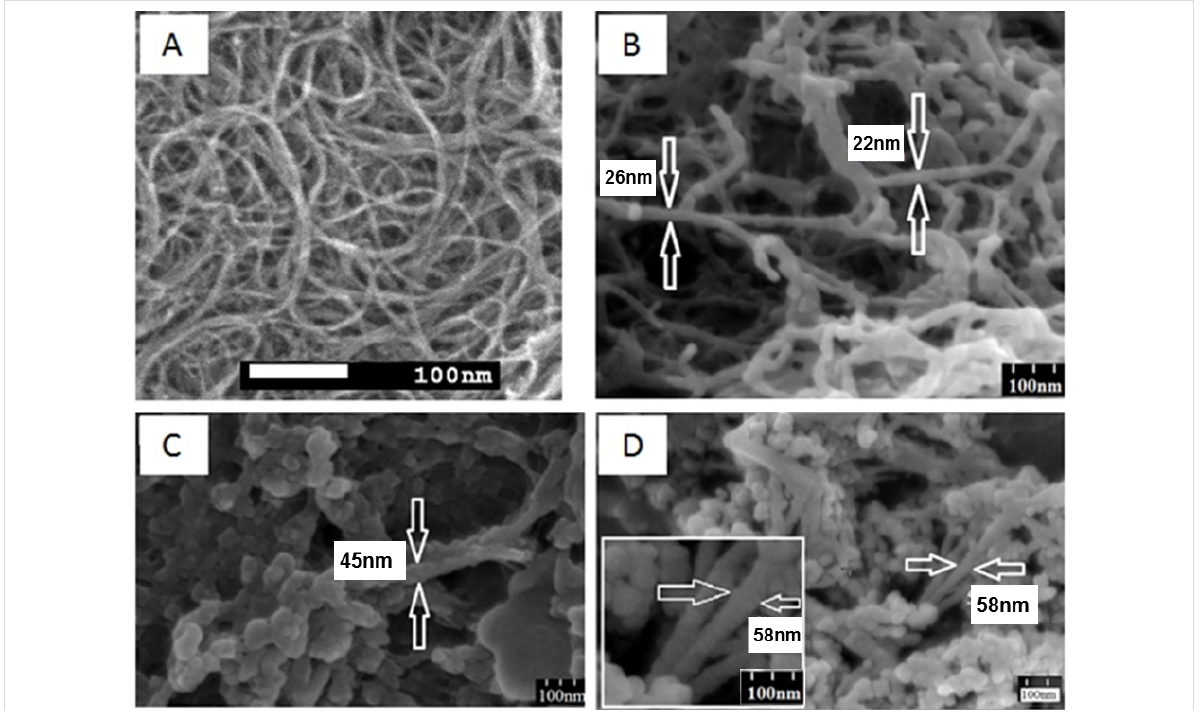
Figure 10: Scanning electron microscope images. (A) undispersed, raw SWNTs; (B) SWNT–CR complexes formed at high 5:1 CR/SWNT ratio (1 mg SWNTs + 1 mL of 5 mg/mL CR): CR covers the entire surface of carbon nanotubes , the diameter of the SWNT–CR complex exceeds 20 nm; (C, D) SWNT–CR complexes formed at very high 10:1 CR/SWNT ratio (1 mg SWNTs + 1 mL of 10 mg/mL CR): CR covers the entire surface of car- bon nanotubes , the diameter of the SWNT–CR complex exceeds 40 nm and more.